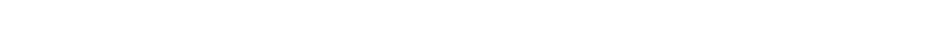
FIGURE 7 | (A) Map of Asia with geographic locations of HGDP populations. PC and factor plots for (B) PCA, (C) spFA, (D)